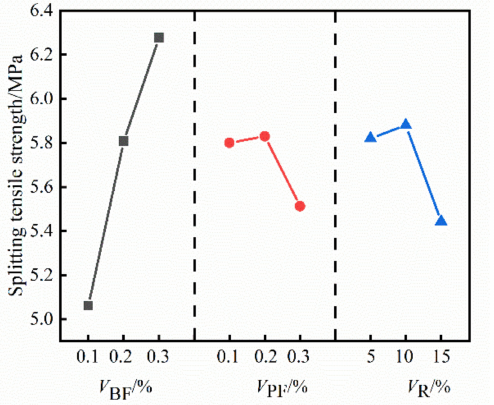
Figure 3. The impact trend of V BF , V PF and V R on the splitting tensile strength of HFRC.